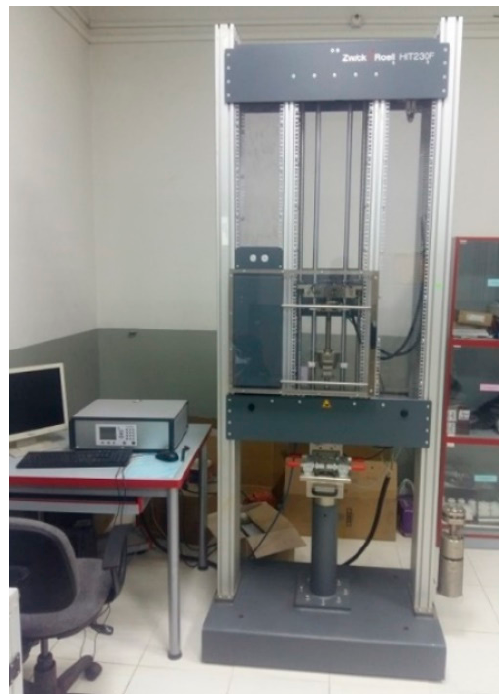
Figure 2. Zwick/Roell universal tensile tester.